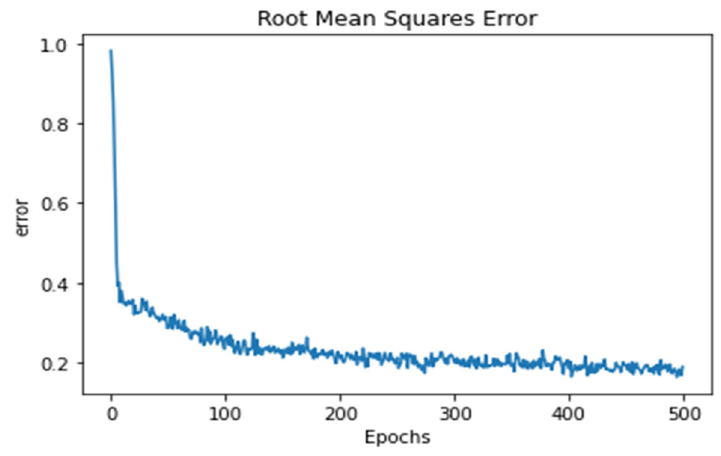
Figure 14. Training MSE